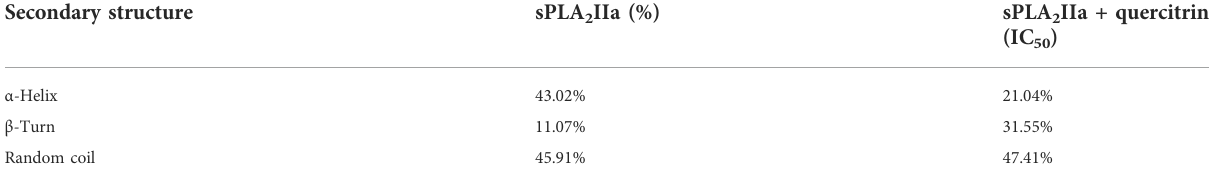
TABLE 2 Effect of quercitrin on secondary structures of sPLA 2 IIA: the secondary structure contents were calculated using K2D3 software.